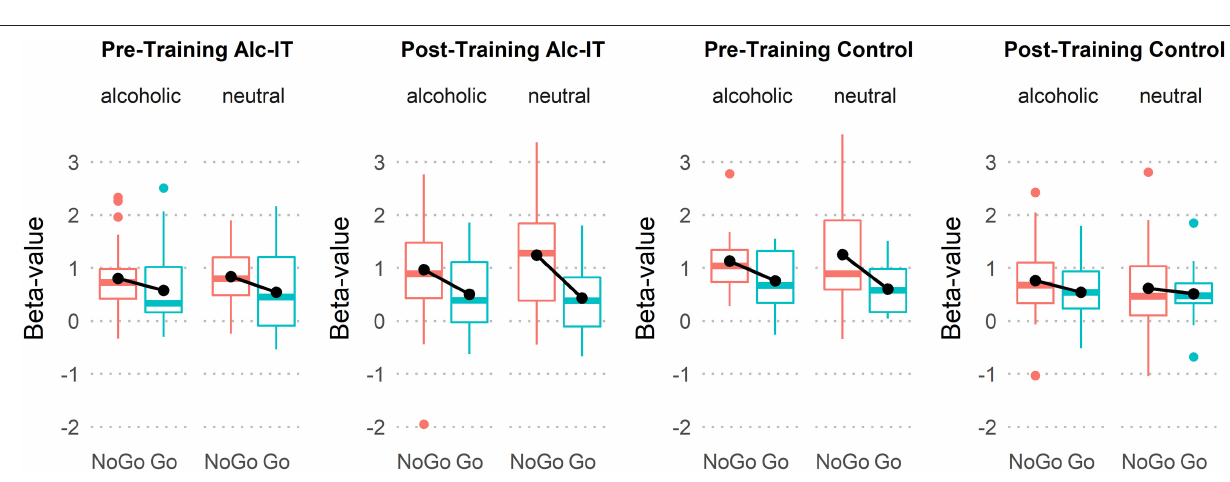
OCDSimp and a visual analog scale to assess craving are shown in Supplementary Figure 3